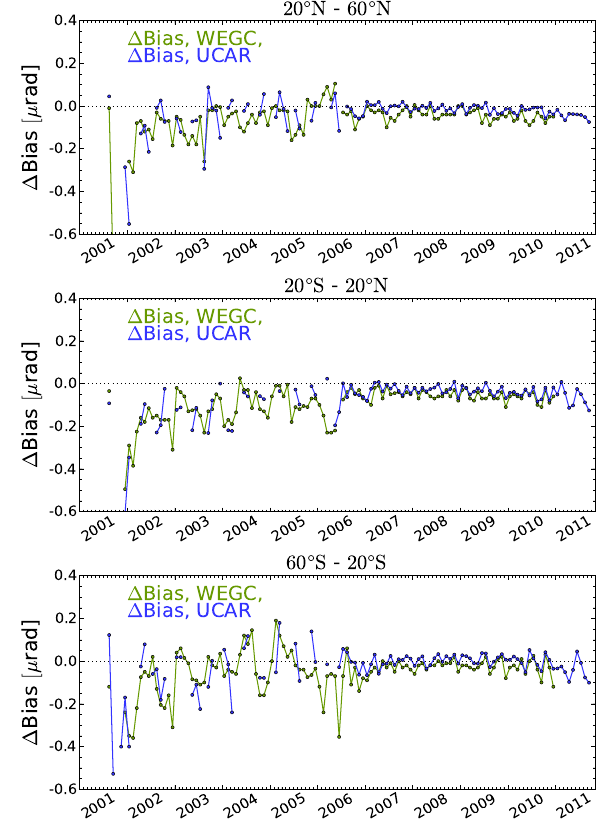
Fig. 3. Nighttime and daytime bending angle bias characteristics over about one solar cycle for WEGC and UCAR bending angle data. From top to bottom we show data from the latitude zones Fig. 4. Difference between day and night time